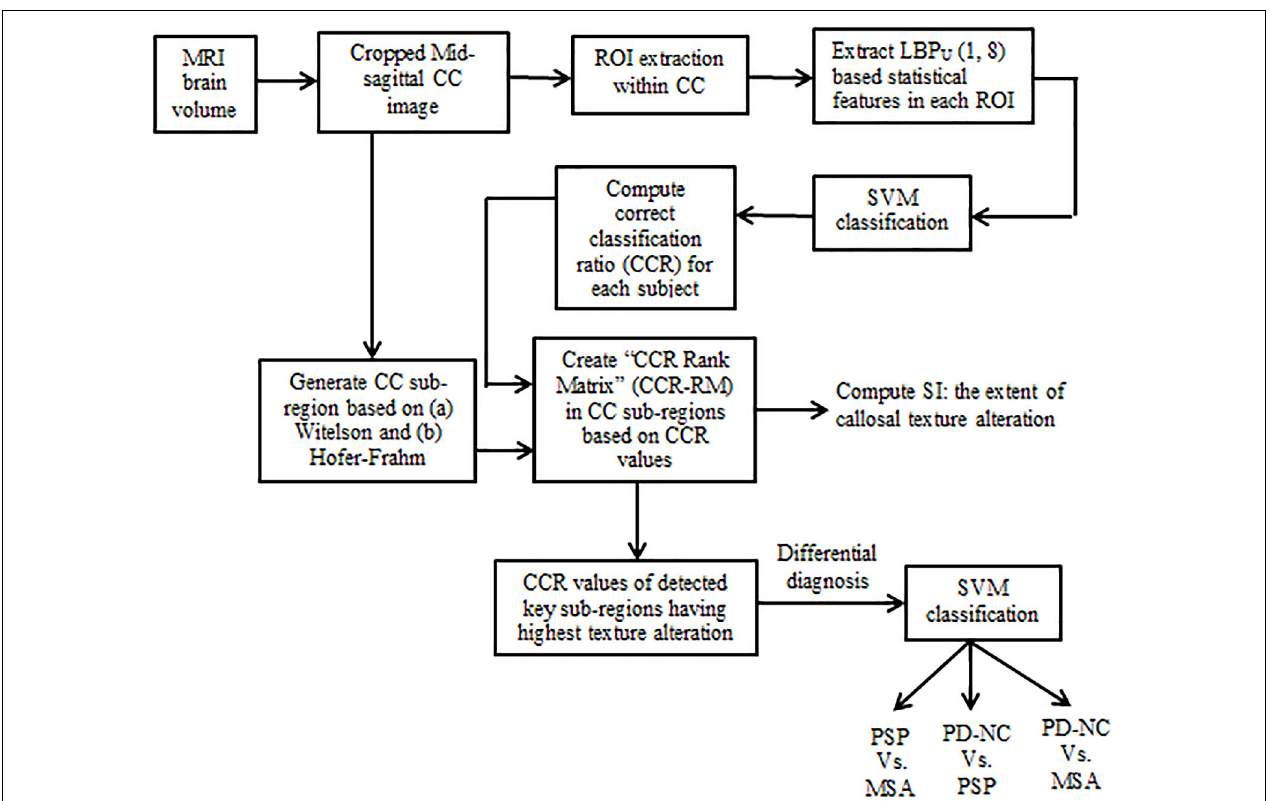
FIGURE 1 | Block schematic of our proposed methodology.